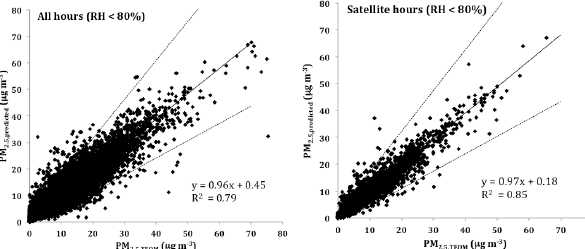
Figure A3. Comparison of predicted hourly fine mass versus mea- sured TEOM PM 2 . 5 for combined NACA, ROMA, and MACA sites (for RH < 80%). Dashed lines show 2 σ confidence interval for pre- dicted PM 2 . 5 RMA slope.